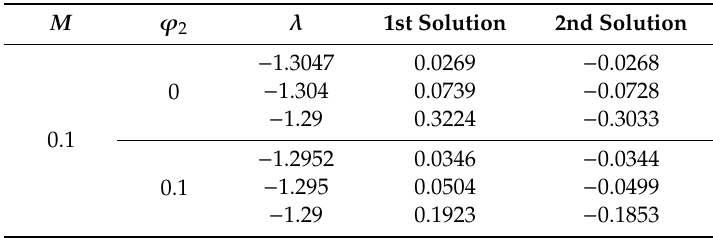
Bi = 0.3, K s = 0.2 and Sc =